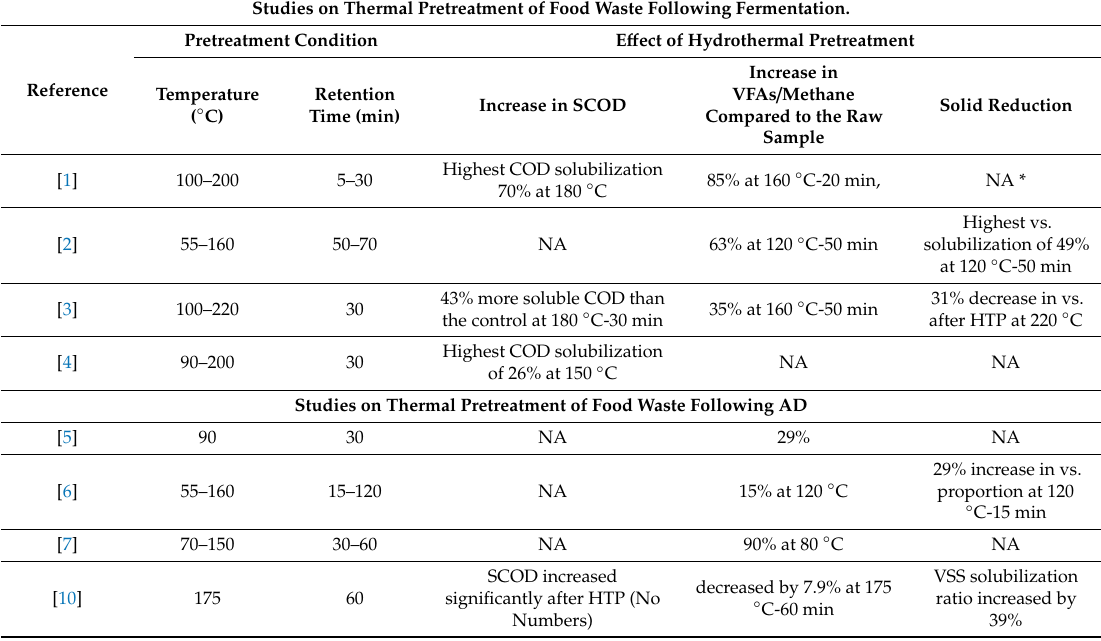
Table 1. Studies on thermal pretreatment of food waste prior to fermentation and anaerobic digestion (AD). Studies on Thermal Pretreatment of Food Waste Following